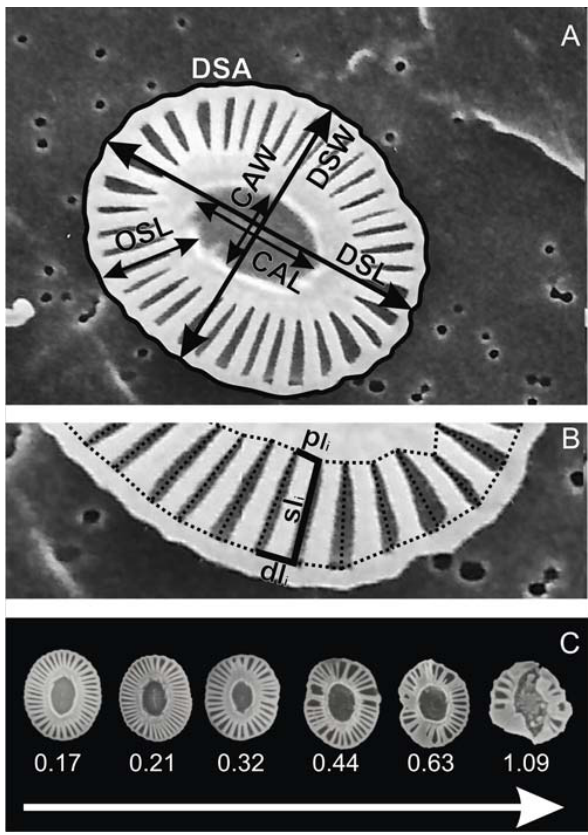
Figure 1. Morphological quantities measured by SEM. (A) Measured size attributes, distal shield area (DSA), distal shield length (DSL), distal shield width (DSW), central area length (CAL), central area width (CAW), and outer shield length (OSL). (B) Measurements for calculation of malformation index, proximal distance between two adjacent slits (pl), length of slit (sl), and distal distance between two adjacent slits (dl). pl, sl, and dl were measured for each slit of the investigated coccolith and then processed with eq. 8. (C) Examples of coccoliths with corresponding malformation calculated from eq. 8. The arrow indicates increasing malformation.